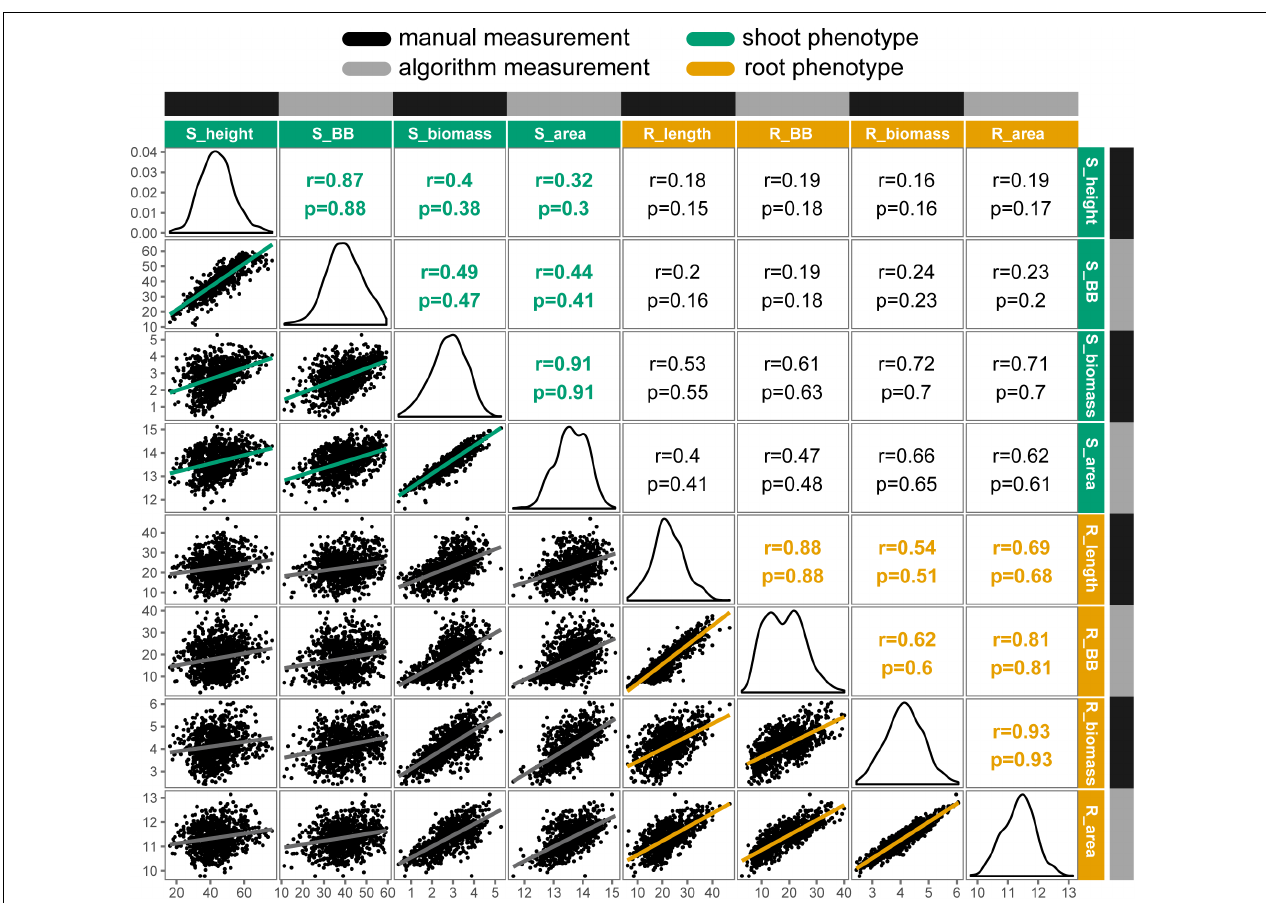
FIGURE 3 | Correlation matrix of selected manual and algorithm measurements in carrot ( n = 917 individuals). Trait distributions are on the diagonal, with Pearson’s correlation coefficients (r) and Spearman’s rho ( ρ ) displayed on the upper triangle and linear relationships on the lower triangle. All correlations were significant at P < 0.001. Trait key: S_height = shoot height (cm); S_BB = shoot bounding box height (cm); S_biomass = shoot biomass (g, fresh); S_area = digital shoot biomass (px); R_length = root length (cm); R_BB = root bounding box height (cm); R_biomass = root biomass (g, fresh); R_area = digital root biomass (px). Note that biomass traits are natural log transformed.